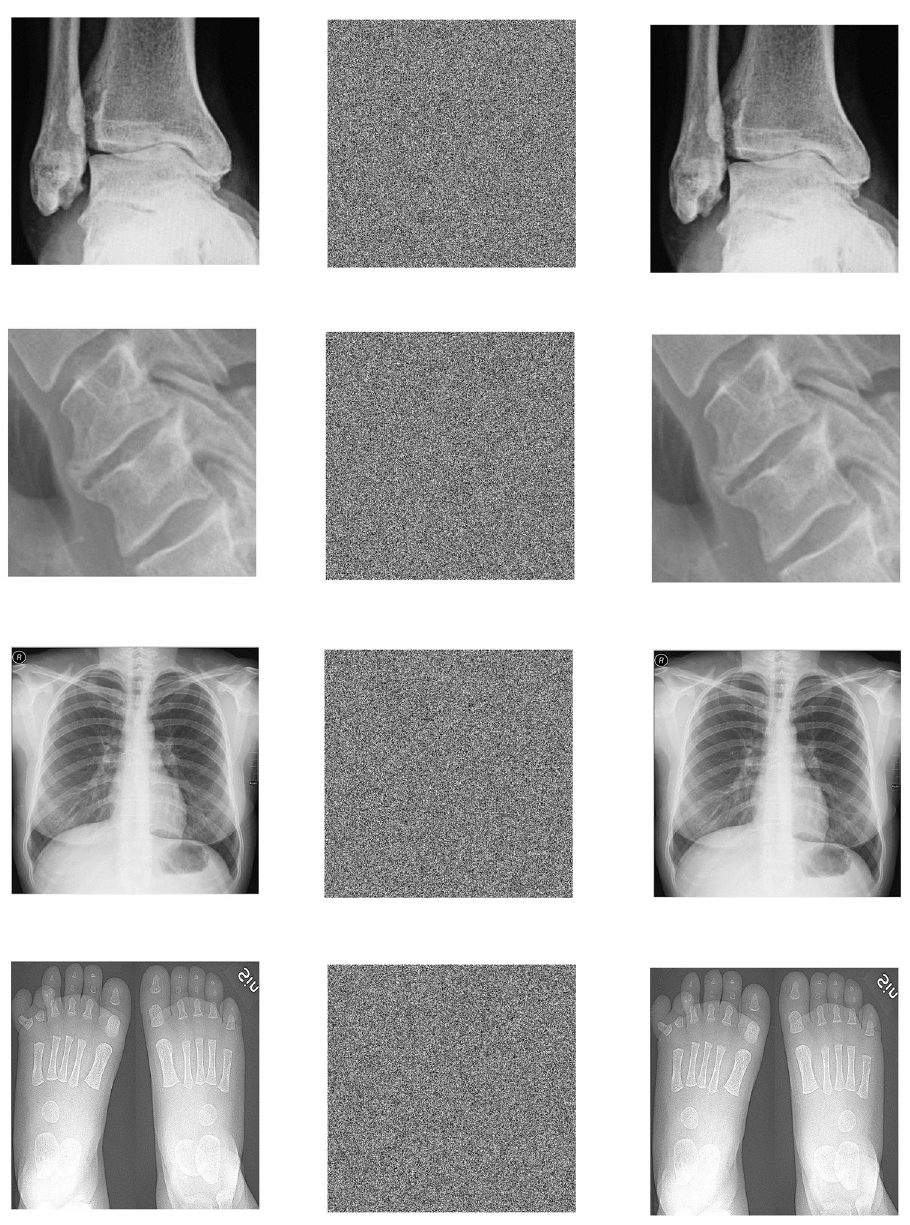
Fig 7. Simulation results of X-ray images. (a) Ankle original image, (b) Ankle encrypted image, (c) Ankle decrypted image, (d) Cervical original image, (e) Cervical encrypted image, (f) Cervical decrypted image, (g) Chest original image, (h) Chest encrypted image, (i) Chest decrypted image, (j) Feet original image, (k) Feet encrypted image, (l) Feet decrypted image. K ( i , j ) represent the pixel value at the corresponding coordinates. MAX mum possible pixel value of the image. If each pixel is represented by 8-bit binary, then it is 255. Select one image from the three types of medical images of MRI, CT and X-ray respectively, and calculate the similarity and PSNR value between the original image and the decrypted image, as shown in Table 12.